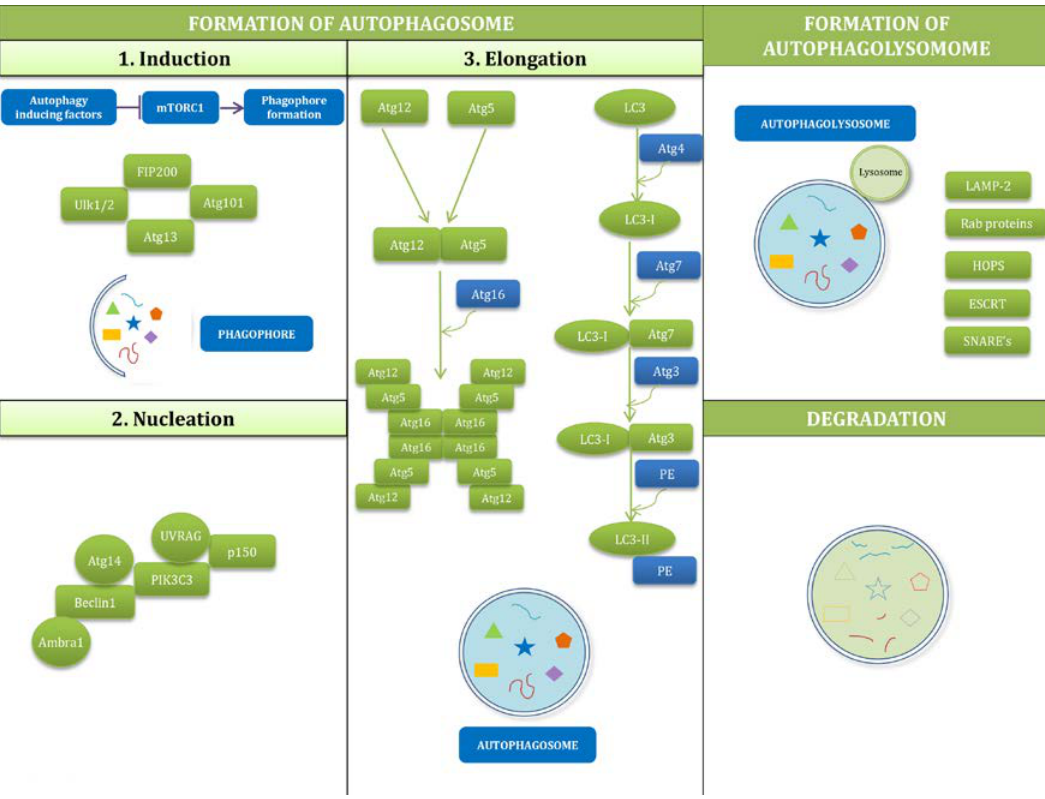
Figure 2. Mechanisms of autophagy. Autophagy can be divided into 3 stages: (1) formation of the autophagosome, (2) formation of the autophagolysosome, and (3) digestion the contents of follicles. Phagophore/autophagosome content: unneeded/misfolded proteins, carbohydrates, lipids, nucleic acids, whole organelles. More information has been provided in part 2.2.